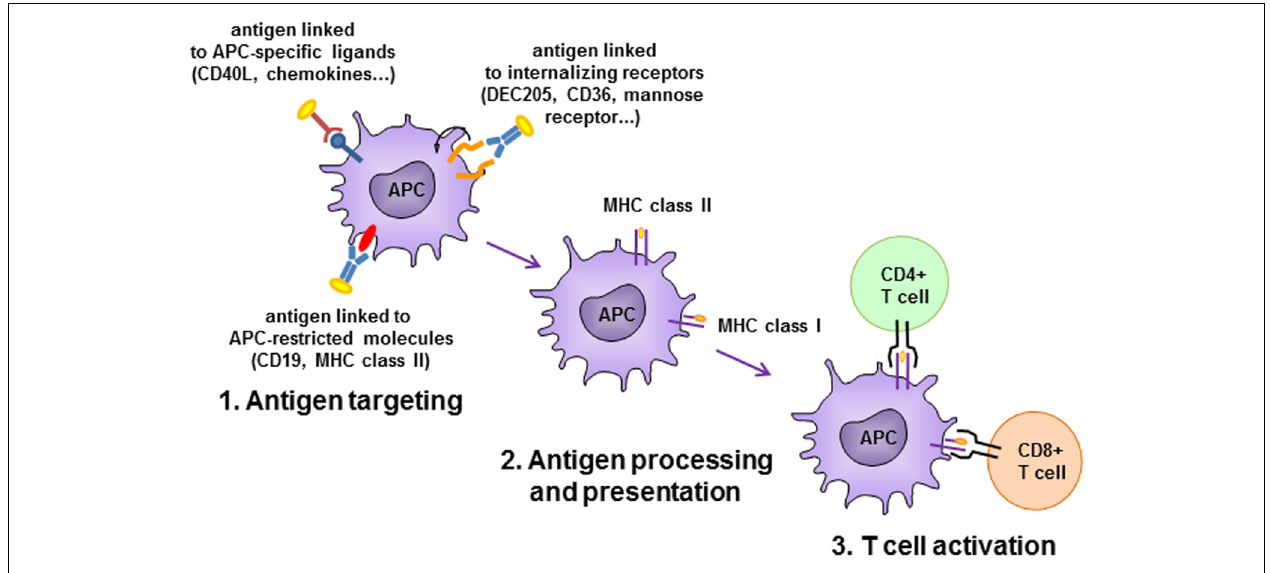
FIGURE 3 |Antigen-presenting cell (APC)-targeting strategies. Antigen is delivered to APC by antibodies specific to APC-restricted molecules or